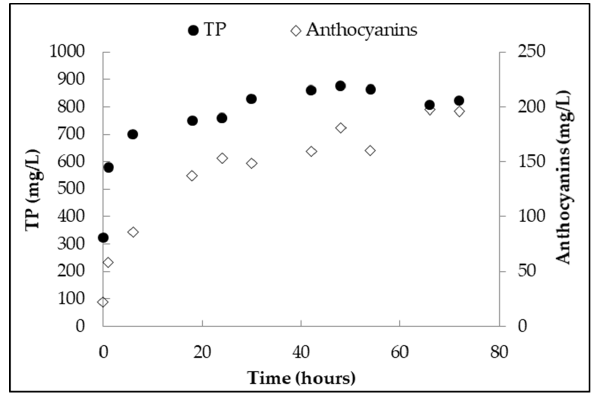
Figure 2. Evolution of total polyphenols (TP) and anthocyanins during processing.